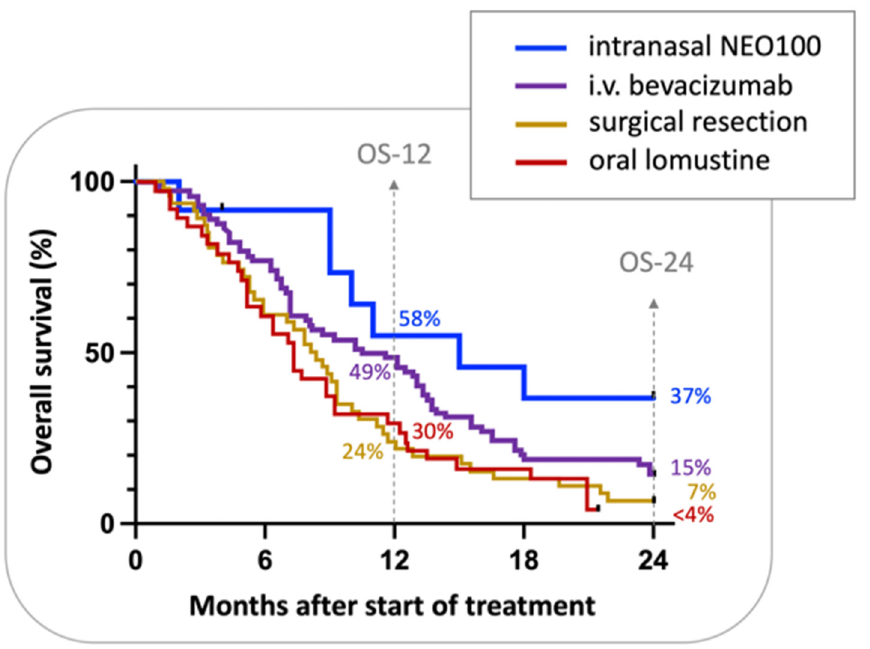
Figure 3. Comparison of the overall survival of recurrent GBM patients. Shown are the Kaplan–Meier curves representing the probability of survival of recurrent GBM patients undergoing different treatment regimens. The blue line indicates results for intranasal POH/NEO100 treatment (n = 12) obtained from a Phase I study [97]. The purple line represents a single-institution retrospective of the clinical real-world experience with bevacizumab (n = 74) [102]. The gold line is a historical comparison from 1998 that monitored the survival of patients after surgical resection of recurrent tumors (n = 46) [99]. The red line represents data from a randomized Phase III trial published in 2013 [100], where patients (n = 65) received lomustine. Percentages shown in the graph refer to the OS-12 and 2-year survival (OS-24) of the different treatment regimens after diagnosis of recurrence.